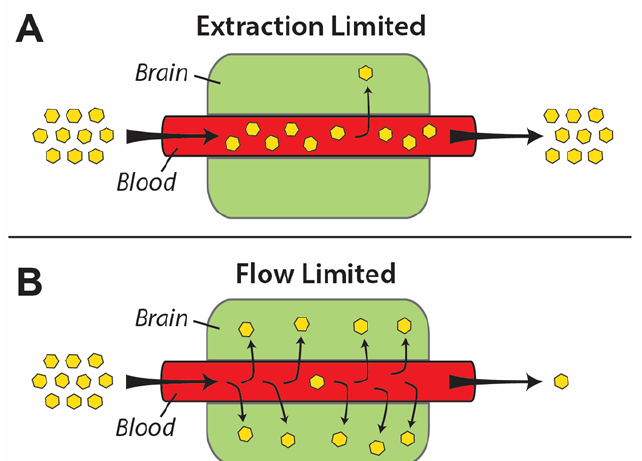
Figure 3. A schematic representation of ( A ) extraction-limited and ( B ) flowlimited solute transfer across the BBB. The physicochemical properties of compounds having extraction-limited permeability are not amenable to BBB transport. Conversely, the transport of highly permeable solutes across the BBB is generally quick, and only limited by how rapidly they are presented to the BBB.